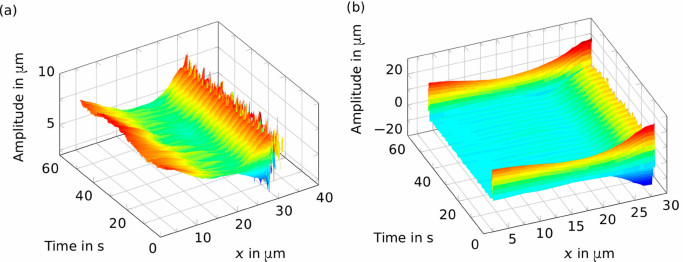
Figure 6. Wiggling bundle position data. Panel ( a ) shows the amplitude of the movement of the bundle contour in the y -direction with respect to its point along the bundle. The bead that is controllably deflected by the optical tweezers setup to induce oscillations is near position x = 27 µ m, and is attached to one end of the bundle. Bundles that are not orthogonal to the oscillation direction were excluded from further analysis. Panel ( b ) shows the data after band passing. The first and last periods need to be excluded from l ω -fitting because of the border effects of